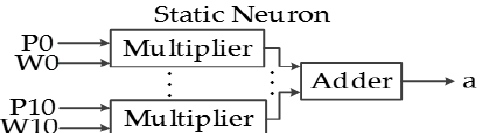
Figure 18. Dynamic neuron hardware.